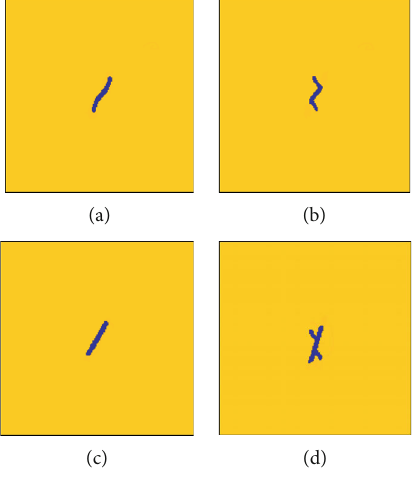
Figure 5: Initiation of the tensile cracks: (a) type I; (b) type II; (c) type III; (d) type IV. Table 1: Schemes of the strength